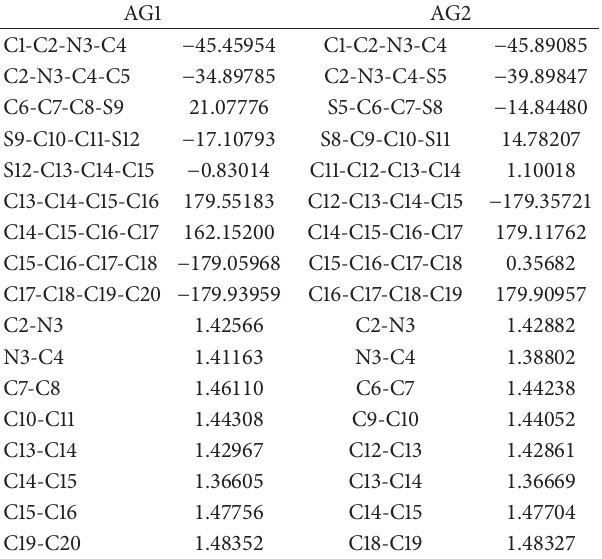
Table 1: Calculated bond lengths and dihedral angle for two compounds, respectively.